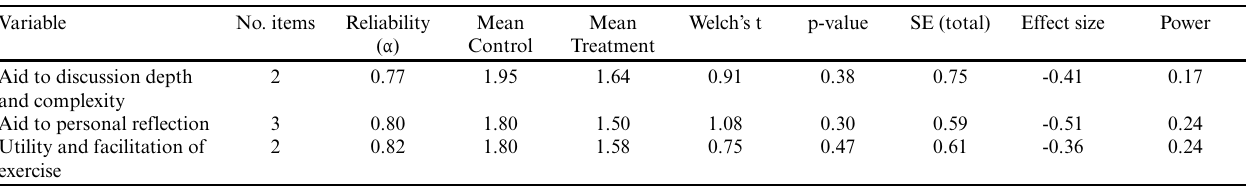
Table 5 . Results between control and